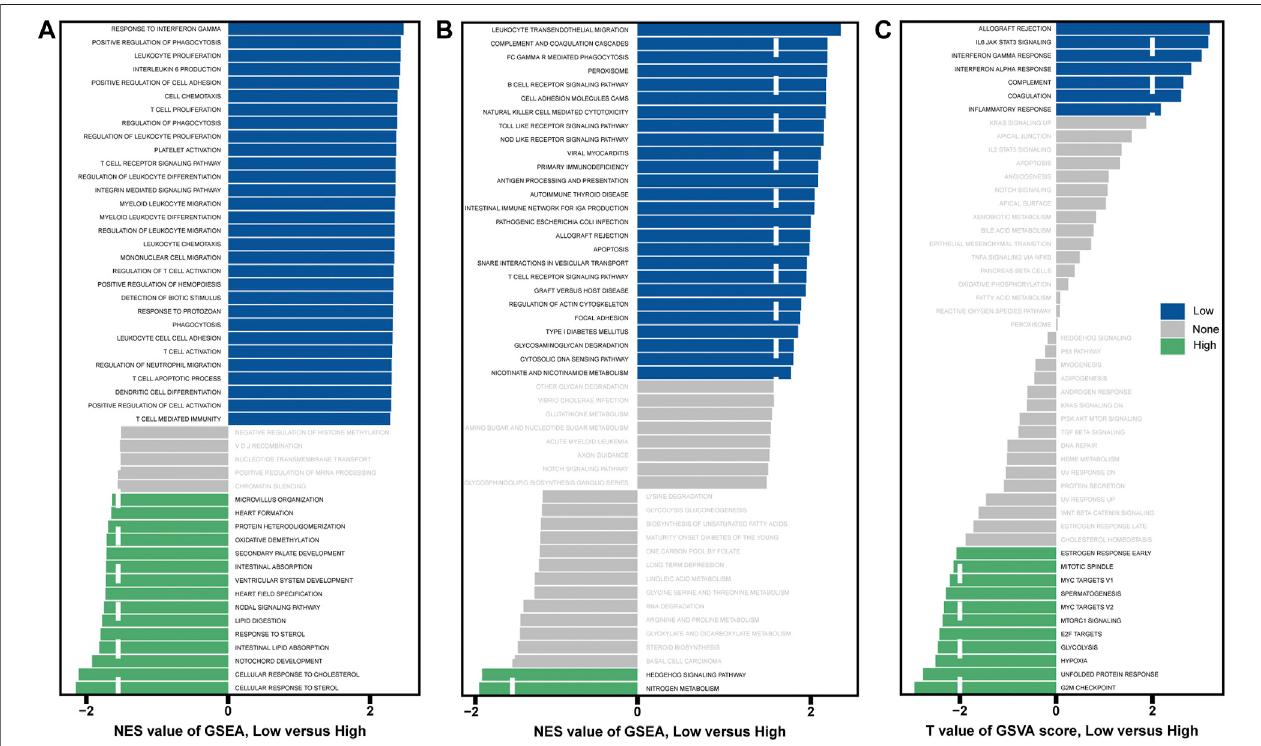
FIGURE 5 | Analysis of GSEA and GSVA in high- and low-risk patients. (A) GSEA with “ c5.go.bp.v7.4.symbols.gmt ” as a reference gene set. (B) GSEA with “ c2.cp.kegg.v7.4.symbols.gmt ” as a reference gene set. (C) GSVA with “ h.all.v7.4.symbols.gmt ” as the reference gene set.